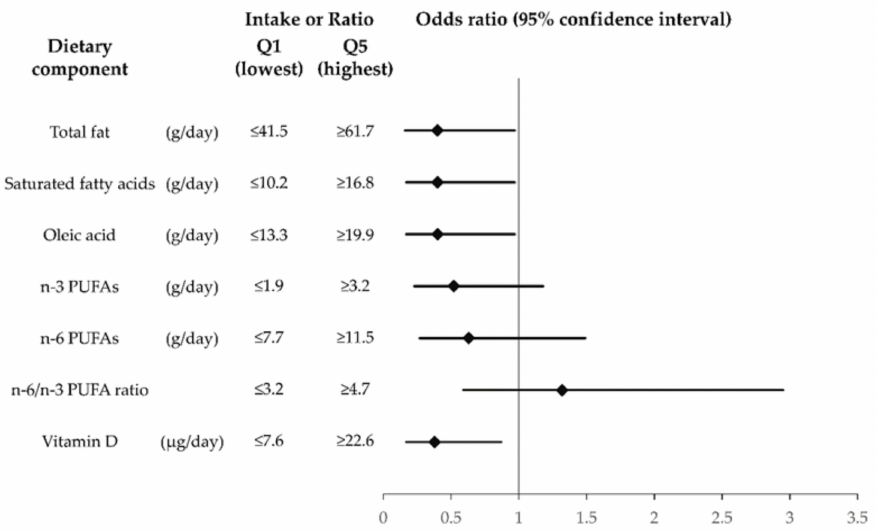
Figure 1. Multivariate adjusted odds ratios and 95% confidence intervals for the prevalence of meibomian gland dysfunction according to extreme quintiles (Q1 and Q5) of intake of specific fats and vitamin D among adult subjects in the Hirado–Takushima study. Nutrient intake was adjusted for energy by the residual method. The results are for Model 2, with adjustment for age (years, continuous), sex (male or female), body mass index (kg/m2, continuous), history of chronic systemic disease (yes or no), and alcohol drinking (yes or no). PUFA, polyunsaturated fatty